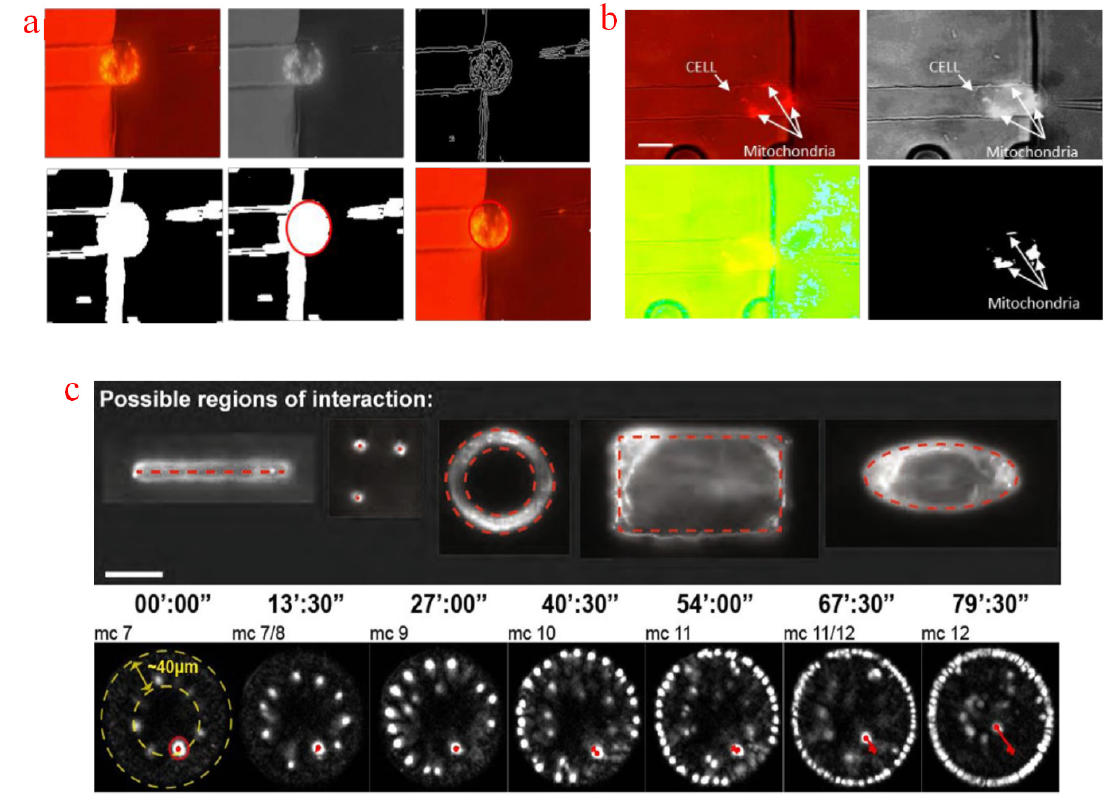
Figure 5. Segmentation of targeted specimen localization. ( a ) Trapped cell detection with a Canny edge detector and a Hough circle transform. Adapted with permission from Reference [124]; ( b ) Mitochondria localization with HSV range value. Adapted with permission from Reference [126]; ( c ) Segmentation of laser ablation region, the red circle indicates the region of interest and the trajectory shows the targeted nucleus movement. Adapted with permission from Reference [127].